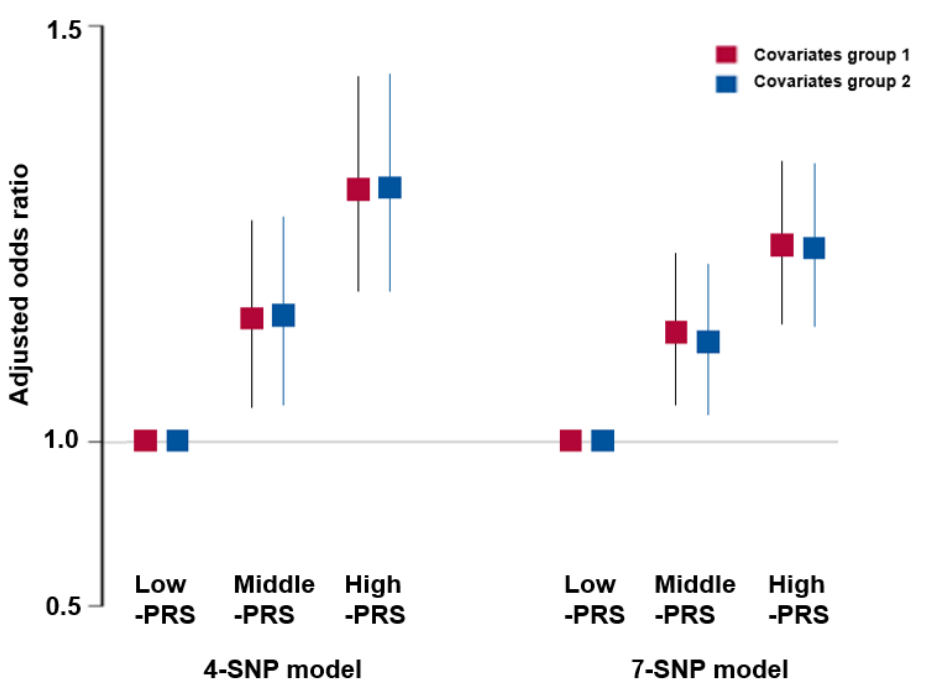
Figure 2. Adjusted odds ratio (ORs) and 95% confidence intervals (CI) of 4-SNP PRS and 7-SNP PRS models for tall stature PRS was generated with the sum of the number of risk alleles in each SNP, and it was classified as Low-PRS, Middle-PRS, and High-PRS according to the range 0–3, 4–5, and ≥ 6 in the four-SNP model and 0–5, 6–7, and ≥ 8 in the six-SNP model, respectively. Covariates of group 1 included age, gender, weight, residence area, education, and income, and those of group 2 contained those in group 1 plus energy intake, exercise, alcohol drinking, smoking, and osteoporosis incidence.